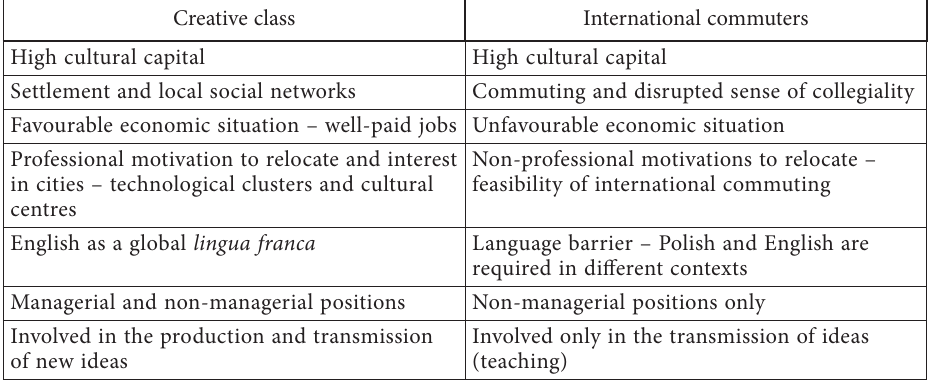
Table 3. Foreign-born commuting academics as creative class (source: created by